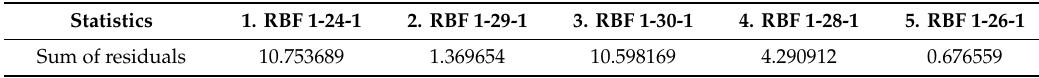
Table 5. Sum of residuals of individual equalized time series.